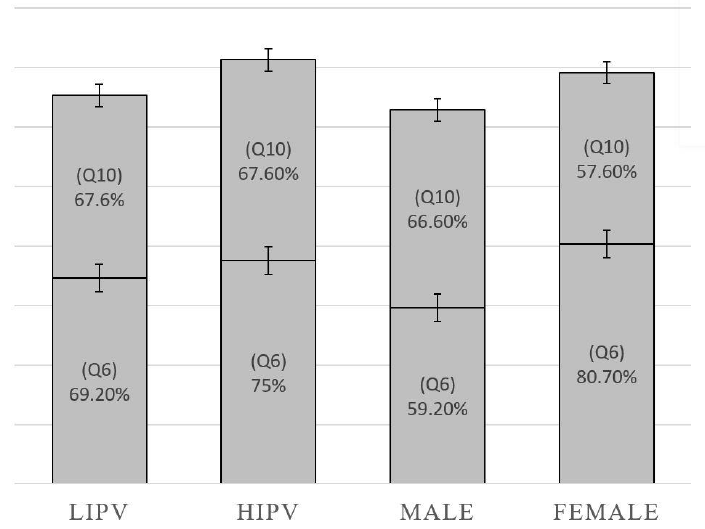
Figure 12. The rate of the right answer for the memory question referred to the answers of (Post-Q.6) and (Post-Q.10) in post-questionnaire.